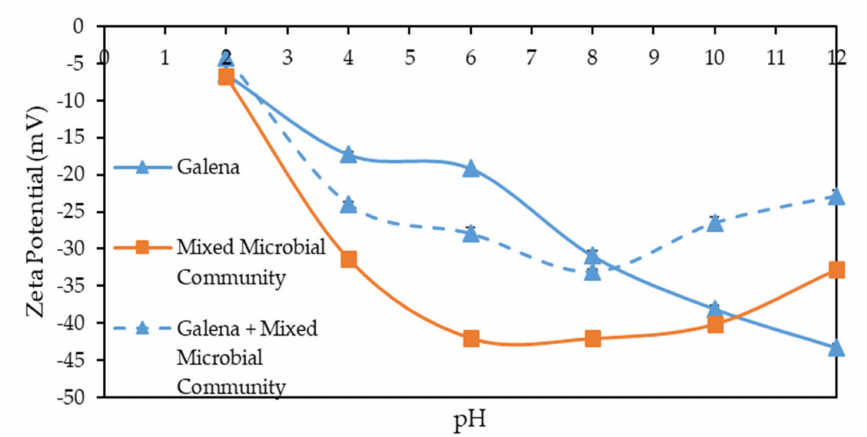
Figure 2. Zeta potentials of galena, microbes and galena after interaction with 1 × 10 8 cells / mL of mixed microbial